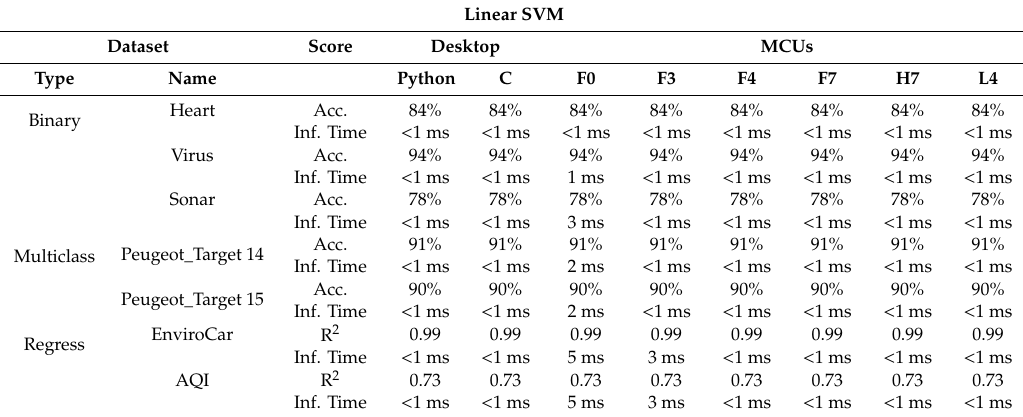
Table 8. Linear Support Vector Machine (SVM) performance.